Question: Condense the content of this figure into a single sentence.
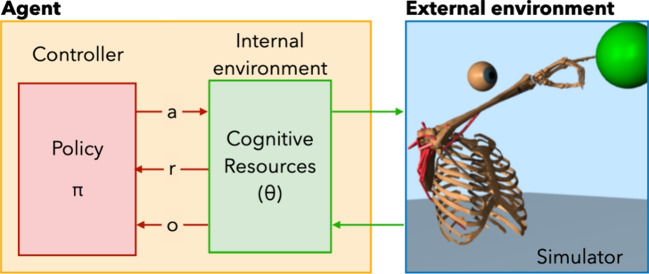
Answer: Computational rationality assumes that people adapt their behavior to maximize expected utility under cognitive bounds. To build a computational model that instantiates this theory with reinforcement learning, a policy ( \documentclass[12pt]{minimal} \usepackage{amsmath} \usepackage{wasysym} \usepackage{amsfonts} \usepackage{amssymb} \usepackage{amsbsy} \usepackage{mathrsfs} \usepackage{upgreek} \setlength{\oddsidemargin}{-69pt} \begin{document}$$\pi $$\end{document} π ) needs to specify a decision problem where a policy ( \documentclass[12pt]{minimal} \usepackage{amsmath} \usepackage{wasysym} \usepackage{amsfonts} \usepackage{amssymb} \usepackage{amsbsy} \usepackage{mathrsfs} \usepackage{upgreek} \setlength{\oddsidemargin}{-69pt} \begin{document}$$\pi $$\end{document} π ) controls which action ( a ) to take in light of observations ( o ) to maximize rewards ( r ). Whereas standard reinforcement learning-based models applied in ML are situated directly in the external environment, computationally rational models of human behavior are only “yoked to it” via their internal environment, that is, cognition. Modeling the decision-making problem, including the internal environment, as well as its parametric variability across individuals ( \documentclass[12pt]{minimal} \usepackage{amsmath} \usepackage{wasysym} \usepackage{amsfonts} \usepackage{amssymb} \usepackage{amsbsy} \usepackage{mathrsfs} \usepackage{upgreek} \setlength{\oddsidemargin}{-69pt} \begin{document}$$\theta $$\end{document} θ ), is a challenge in cognitive science